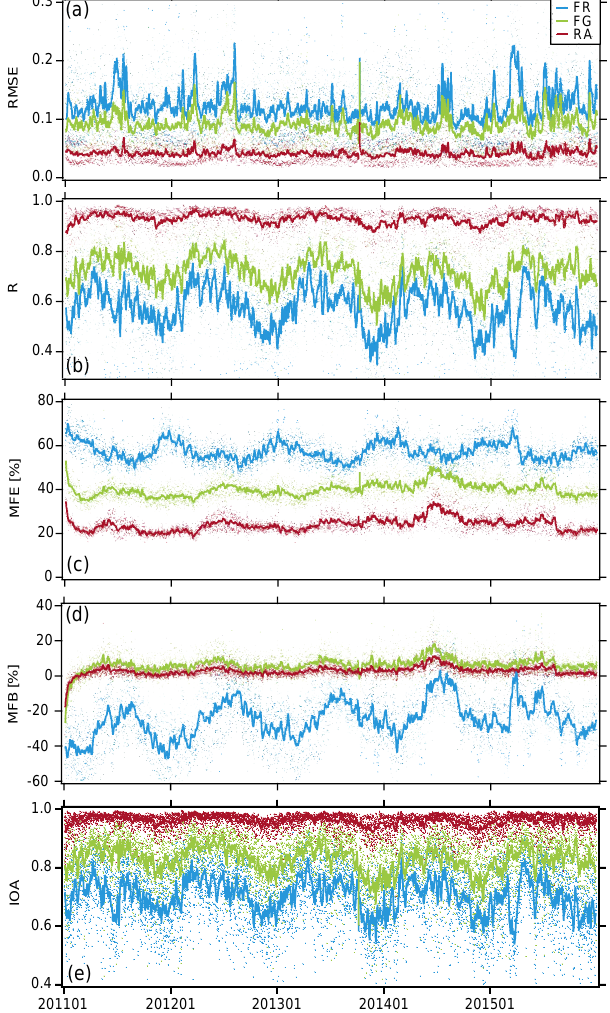
Figure 7. Time series of the 5-day moving average of (a) RMSE, (b) R , (c) MFE, (d) MFB, and (e) IOA for FR (blue), FG (green), and RA (red), validated by NRL-UND MODIS AODs. Small dots show 6-hourly